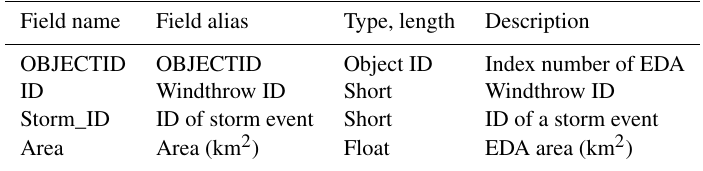
Table 1. Attribute table of the GIS layer of elementary damaged areas (EDAs).